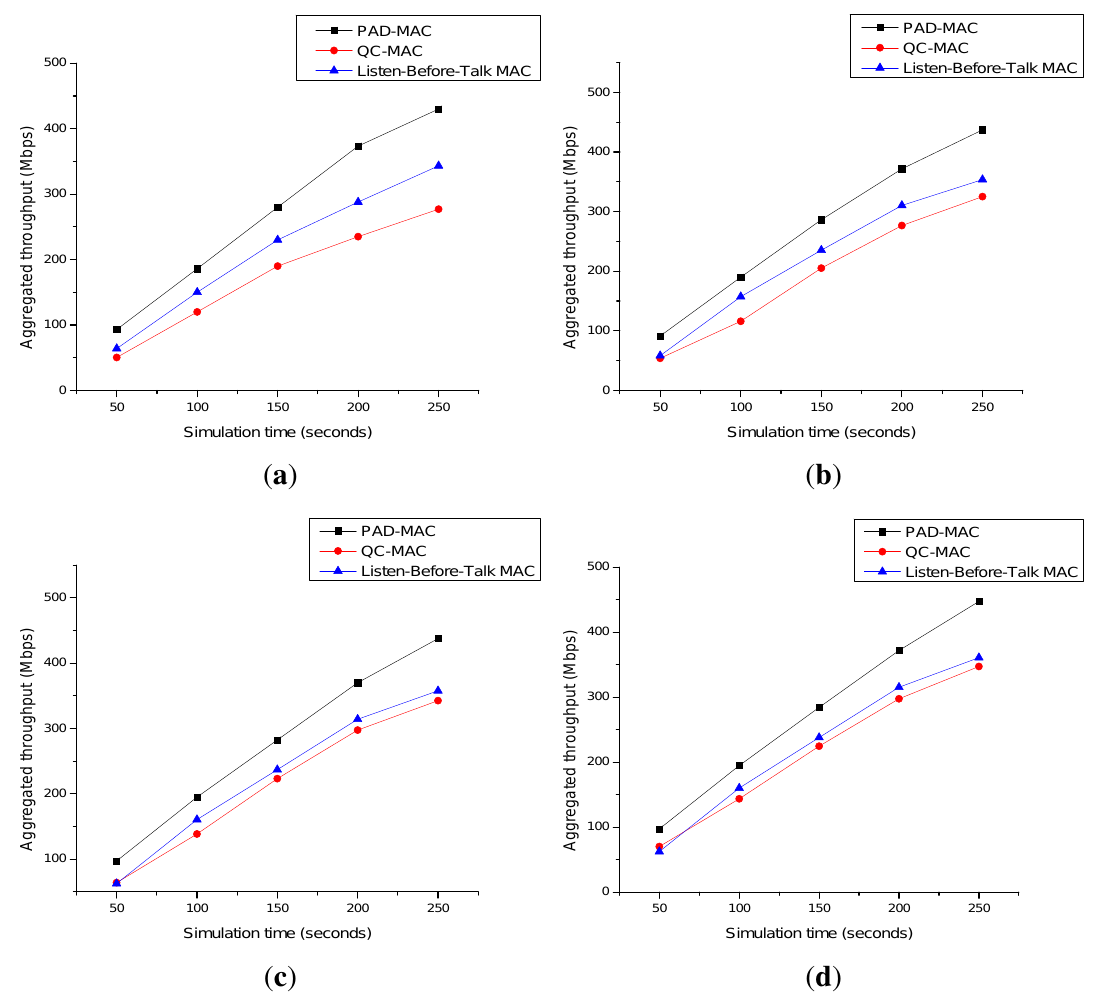
Figure 16. Aggregated throughput. ( a ) Three channels; ( b ) five channels; ( c ) seven channel; ( d ) ten